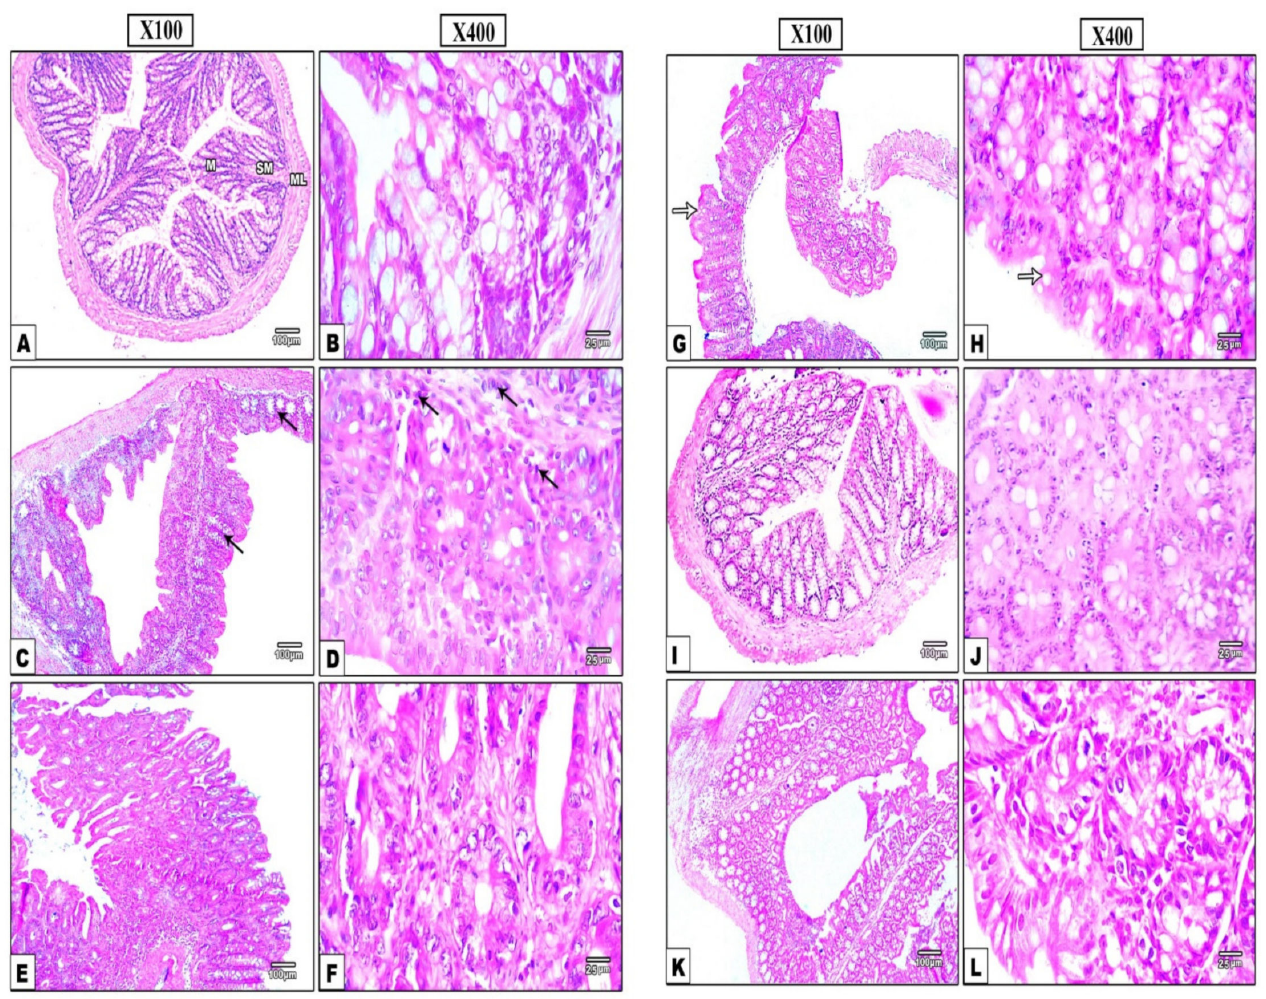
Figure 6. Hematoxylin and eosin stained colonic sections representing the histopathological changes. ( A , B ) show normal mucosal layers (M), submucosa (SM) and musculosa (ML) of saline group. Mucosal surface shows integral columnar epithelium, acidophilic cytoplasm and basal oval nuclei, flask-shaped goblet cells with vacuolated cytoplasm and flattened nuclei at the base (White arrow), crypts with normal shape and narrow openings, and between crypt normal connective tissue of lamina propria. ( C , D ) show hyperplastic distorted mucosa of Di-MH group lined by improperly packed cells having hyperchromatic nuclei (black arrow), disintegrated goblet cell, morphologically altered crypts, and lamina propria with inflammatory cell infiltration. ( E , F ) show distorted architecture in DOX 5 mg/kg treated group with partial moderate (grade 2) dysplasia, numerous goblet cells, and mild inflammatory cell infiltration in between crypts. DOX 10 mg/kg group ( G , H ) display partial moderate (grade 2) dysplasia, and moderate number of goblet cells. DOX-PRNP2 5 mg/kg ( I , J ) and 10 mg/kg group ( K , L ) display a nearly normal mucosal architecture with unaltered crypts, and submucosa. Magnifications of H&E stain X100 bar 100, X400 bar